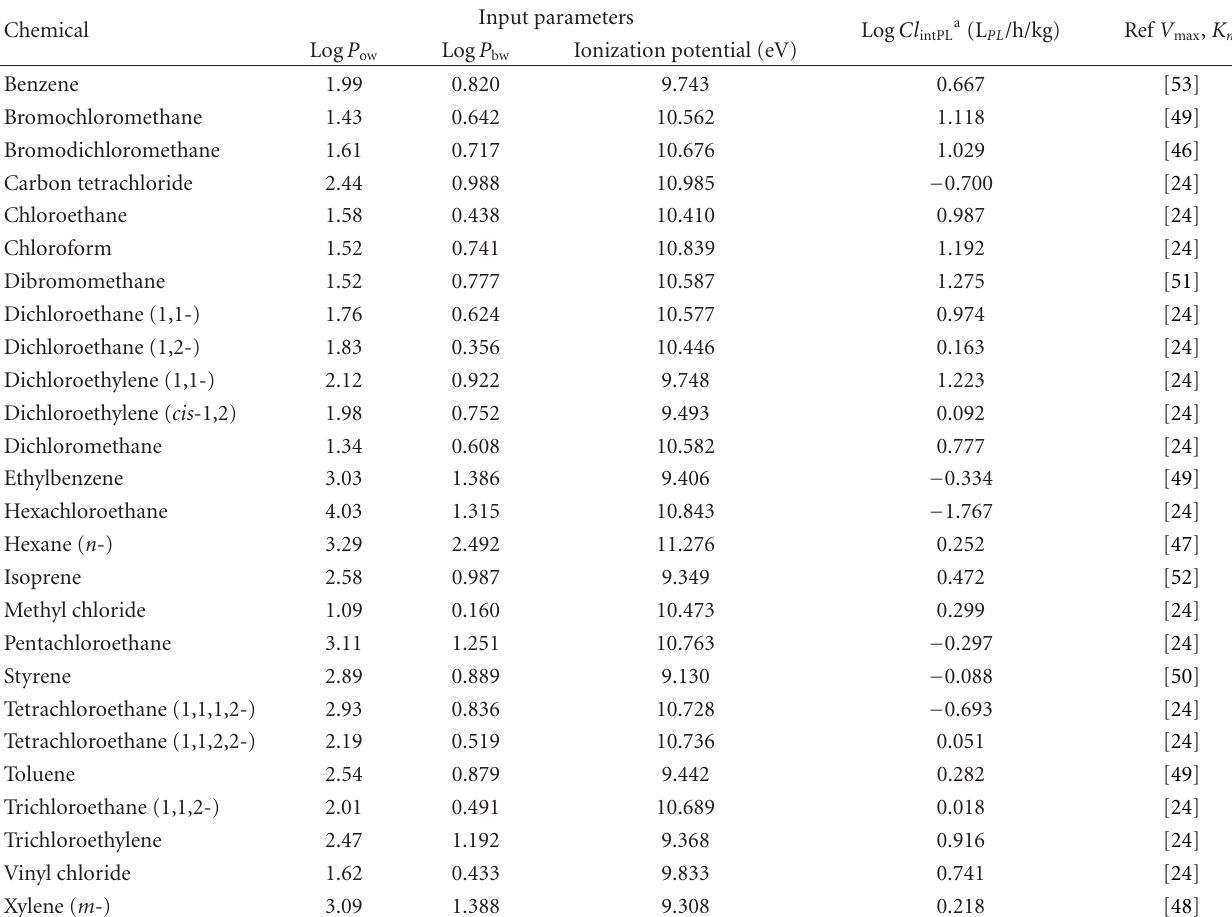
Table 2: Input parameters and experimental data of log CL intPL